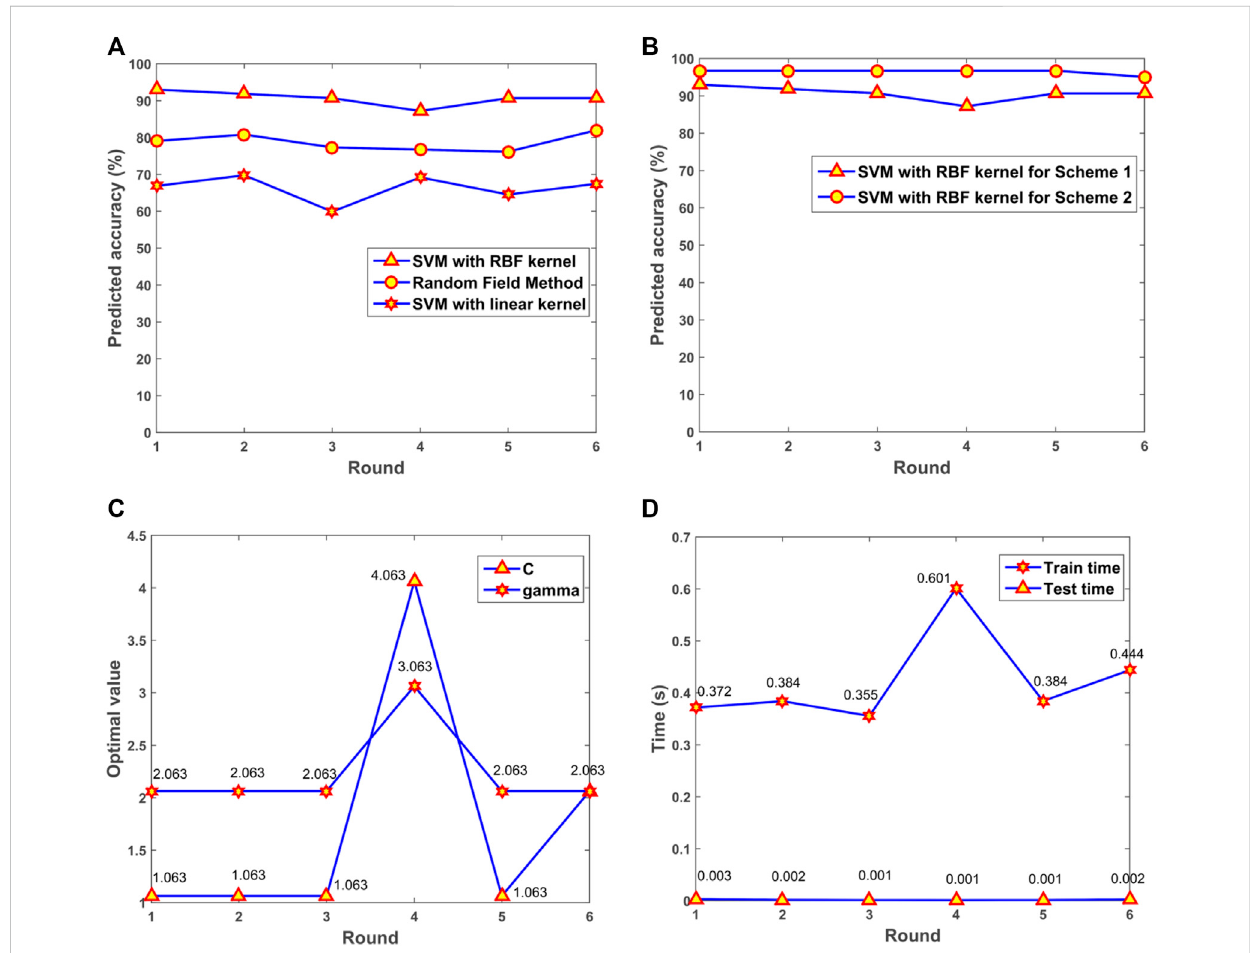
FIGURE 8 The performance of the model. (A) Predicted accuracy of the model with different kernels. (B) Predicted accuracy with different cross-validation schemes. (C) The optimal gamma and C in the 6-fold cross-validation. (D) Consuming time for training and testing processes. SVM, support vector machine; RBF, radial basis